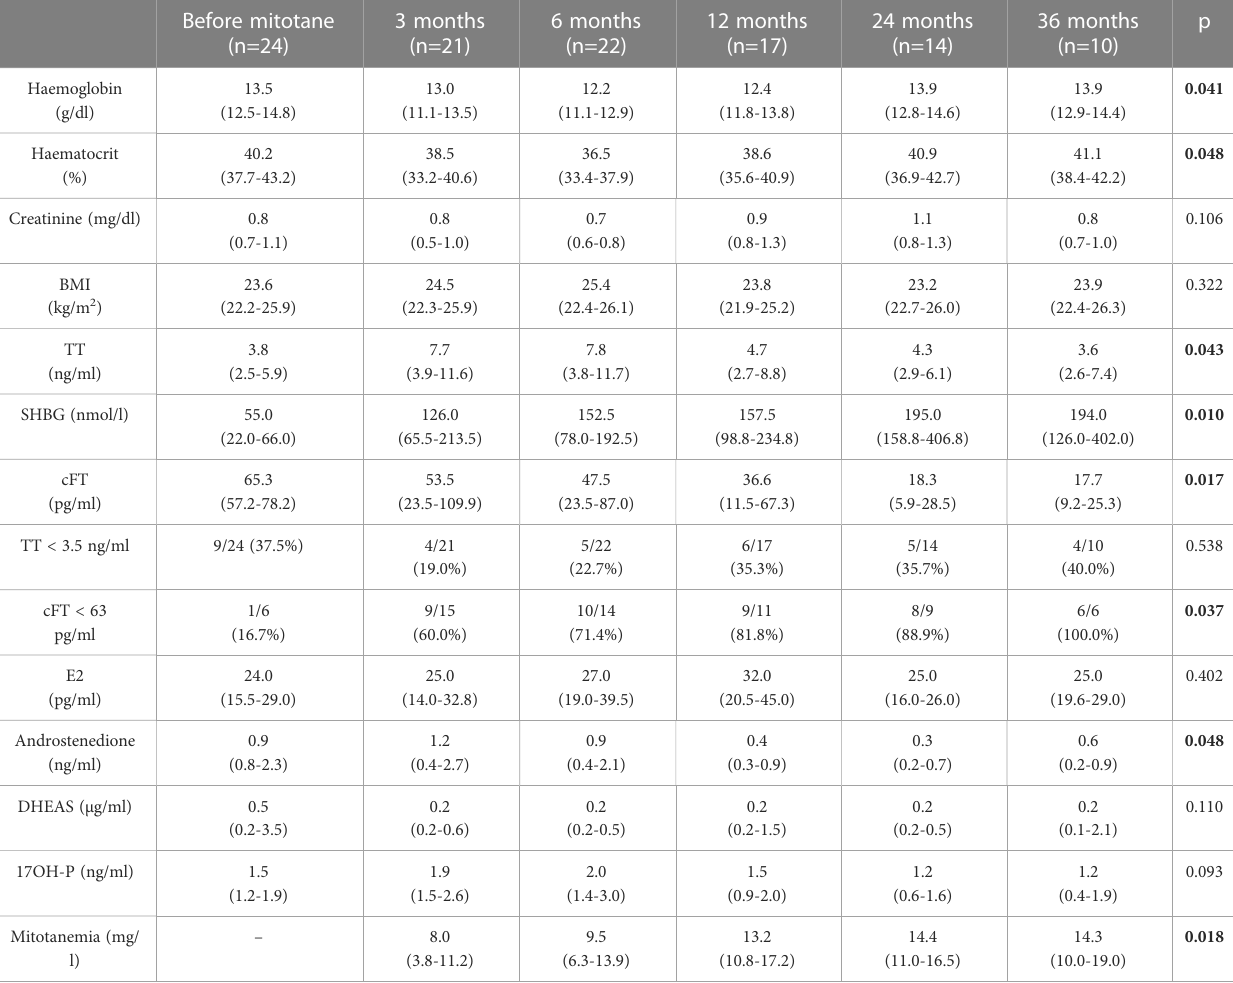
TABLE 3 Variation in biochemical and clinical parameters and serum mitotane levels during follow-up. Before mitotane